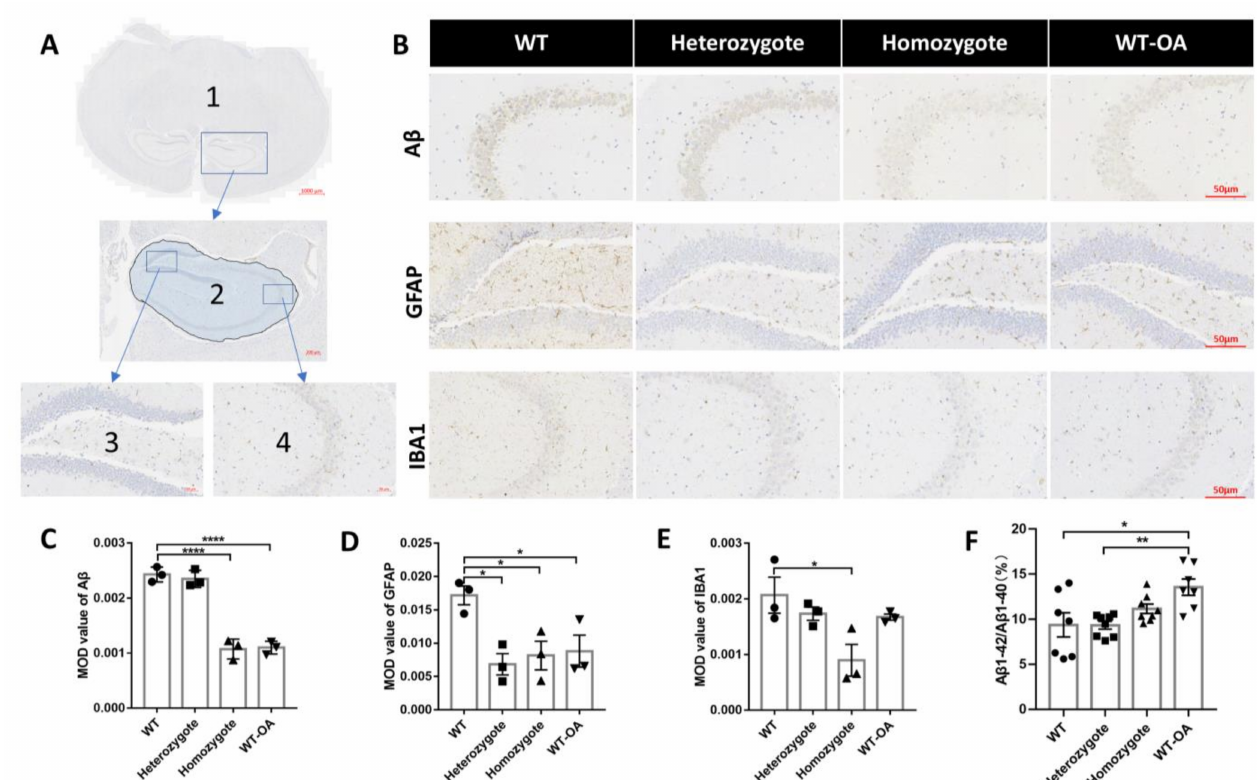
Figure 8. Effect of BChE inhibition on A β , GFAP, and IBA1 expression and the serum A β 1-42/A β 1-40 in 10-month-old mice. ( A ) The schematic diagram for immunohistochemical analysis: Region 1 was a full-scan display of histochemical slice; region 2 was selected for the average optical density analysis of A β , GFAP, and IBA1 expression in the hippocampus; region 3 is the hippocampal DG region and was selected for image display of GFAP, region 4 is the hippocampal CA3 region and was selected for image display of A β and IBA1. ( B ) Representative images of the expression of A β , GFAP, and IBA1 in the hippocampus of 10-month-old mice. Scale bar: 50 µ m. ( C ) Quantitative analysis of the mean optical density of A β expression. ( D ) Quantitative analysis of the mean optical density of GFAP expression. ( E ) Quantitative analysis of the mean optical density of IBA1 expression. ( F ) The ratio of A β 1-42/A β 1-40 in the serum of 10-month-old mice. N = 3 mice per group, 1 image per animal (for C – E ). n = 7–8 mice per group (for F ). Data were shown as mean ± SEM. * p < 0.05; ** p < 0.01; **** p < 0.0001 vs. WT group, one-way ANOVA followed by Tukey’s post hoc